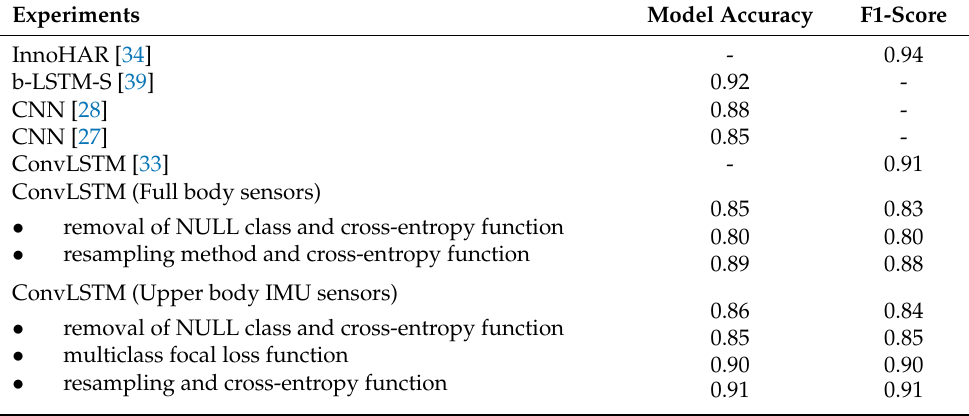
Table 5. Summary of results in this paper compared to previous